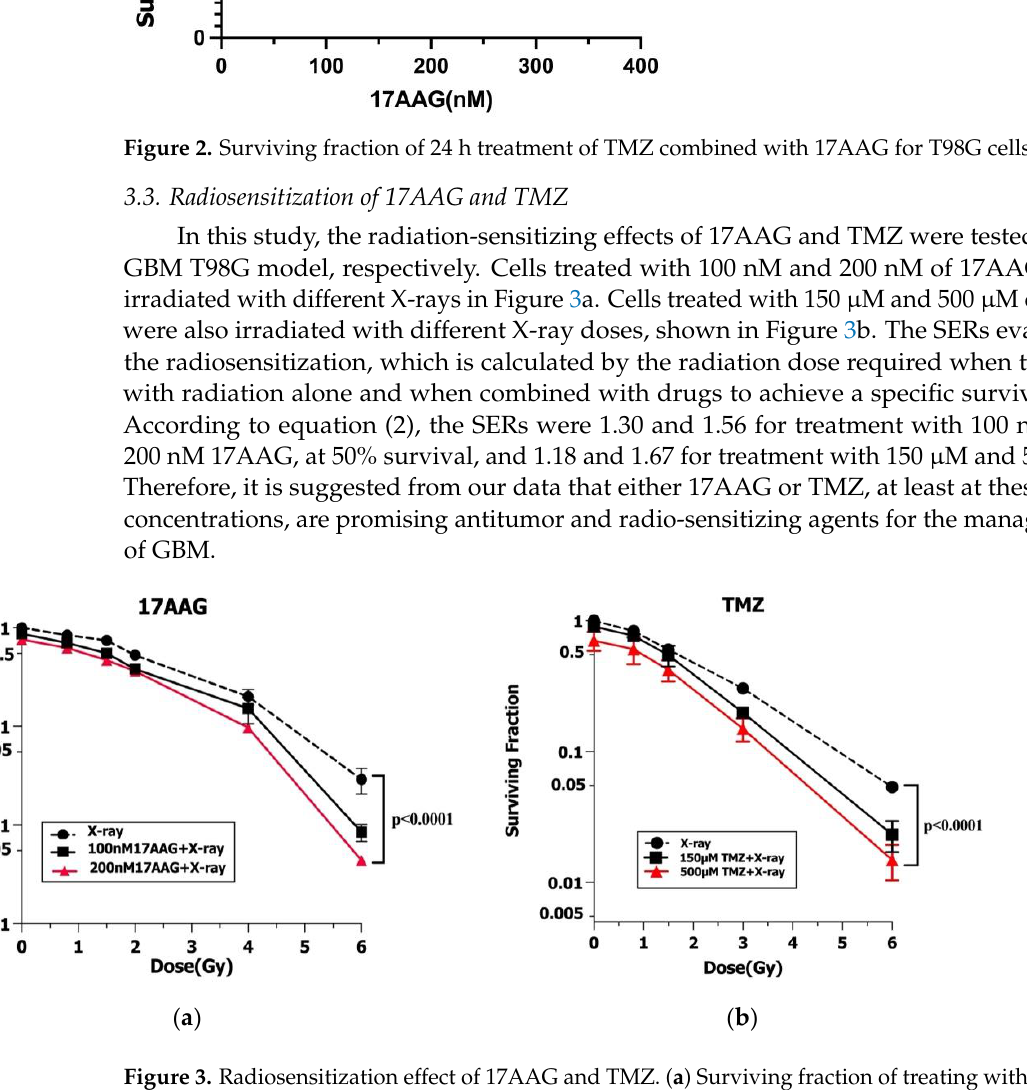
Figure 3. Radiosensitization effect of 17AAG and TMZ. ( a ) Surviving fraction of treating with 17AAG (24 h) and X-ray irradiation (0.57 Gy/min, 130 KV) for T98G cells; SERs for an estimated 50% surviving fraction for T98G cell line and each for 100 nM and 200 nM concentrations of 17AAG; ( b ) surviving fraction of treating with TMZ (24 h) and X-ray irradiation (0.57 Gy/min, 130 KV) for T98G cells; SERs for an estimated 50% survival fraction for T98G cell line and 150 µ M and 500 µ M concentrations of